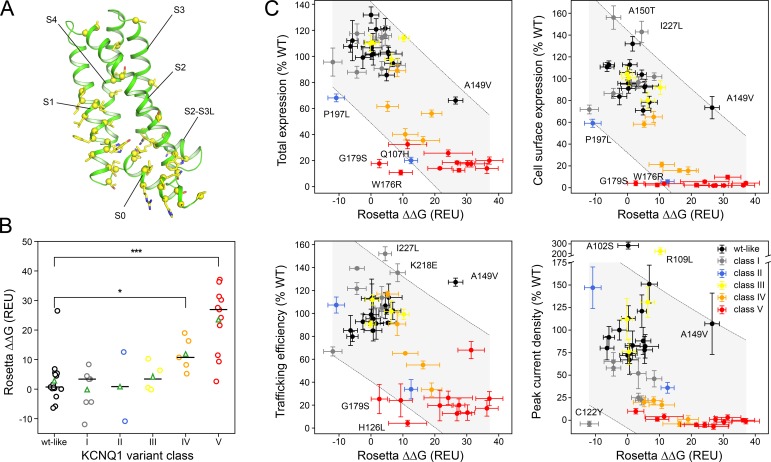
Computationally predicted stability changes of KCNQ1 variants with mutations in the VSD.(A) Location of mutation sites in the KCNQ1 VSD. Backbone sites are mapped by yellow spheres and the native amino acid residue is indicated by yellow sticks. (B) Distribution of Rosetta ΔΔG values for the six functionally distinct classes of KCNQ1 VSD variants [19] (i.e. WT-like and classes I to V for non-functional variants) calculated with the AO homology model. The median and average values are drawn as a black horizontal line and a green triangle, respectively. The median of class IV and V is compared to that one of WT-like variants using a Kruskal-Wallis H-test (* p < 0.05, ** p < 0.01, *** p < 0.001, nWT-like = 15, nIV = 5, nV = 11). ΔΔG values for mutations to proline are off-scale (ΔΔGL114P = 70.5 ± 4.1 REU, ΔΔGL131P = 76.0 ± 3.0 REU, ΔΔGL134P = 68.3 ± 4.1 REU, ΔΔGR195P = 56.8 ± 2.0 REU, ΔΔGQ234P = 71.0 ± 5.0 REU, ΔΔGL236P = 65.8 ± 6.0 REU) due to incompatible backbone torsions in the starting model yielding bad backbone and proline ring geometries and were not used in the analysis. (C) Correlation plots of total expression level, cell surface expression, trafficking efficiency and channel peak current density versus calculated Rosetta ΔΔG values (mean ± S.E.M.). KCNQ1 variant classes are indicated with different colors. Variants falling outside of or being close to the boundary of the 95% confidence interval for a linear regression model (gray shaded area) are labeled and their structural models are shown in S11 Fig in the supplement. The experimental data and mutant classification scheme are from reference [19] and are listed together with the computed ΔΔG values for RC and AO models in S2 Table. Class I variants traffic normally but exhibit channel LOF. Class II mutations induce mistrafficking, but do not alter the functionality of the small population of correctly-trafficked channel. Class III variants traffic normally and are conductive, but exhibit altered channel regulation. Class IV mutations cause mistrafficking and channel LOF. Class V variants are expression and trafficking-defective and have so low current that channel function is unmeasurable.